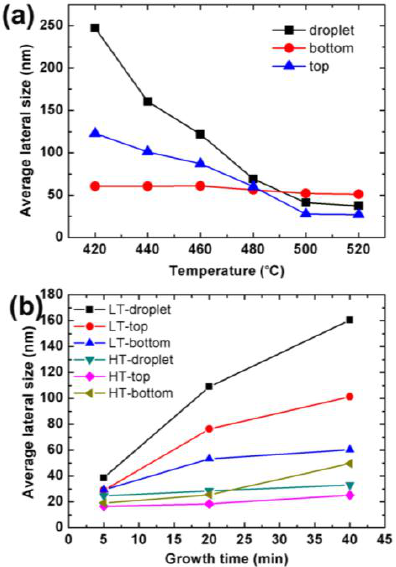
Figure 8. The statistical average lateral size of the droplets, the bottom, and the top parts of the nanowires at different growth conditions. ( a ) The lateral size of the droplets and nanowires grown at different temperatures; ( b ) The lateral size of the droplets and nanowires grown for different time at a low temperature (LT, 440 °C) and a high temperature (HT, 500 °C), respectively.